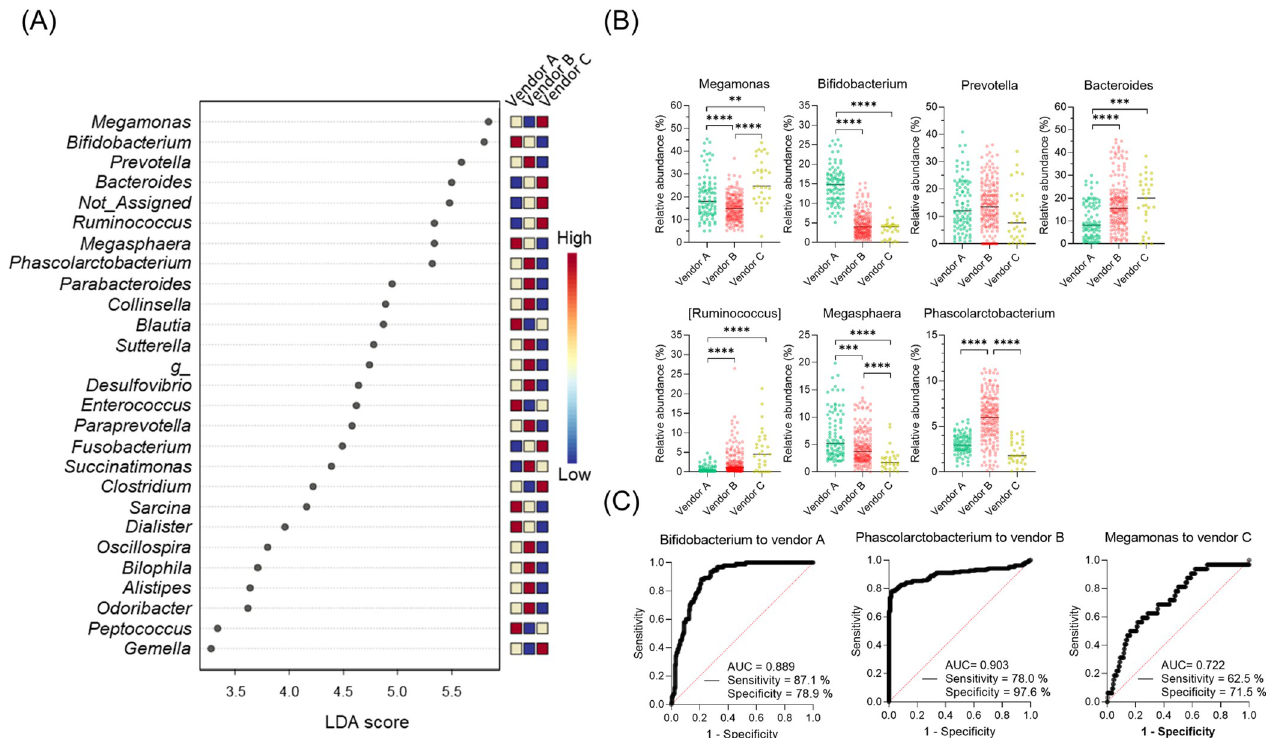
Fig 3. Bacterial characteristics among the fecal microbiome of vendors. (A) Results of the LEfSe analysis comparing vendors. FDR-adjusted p-value < 0.05; the LDA log score is 2.0; figures showed an LDA score over 3.0 as the absolute value. Color bar scale shows the LDA score height. (B) Scatter plots comparing the relative abundance of seven genera among vendors. Each symbol shows each sample, and the line of middle of the box shows the median. Kruskall-Walis test followed by Dunn’s multiple comparison test; p-value: ���� , < 0.0001. ��� , < 0.001. �� , < 0.01. (C) ROC curves with the bacterial genera characteristic of each